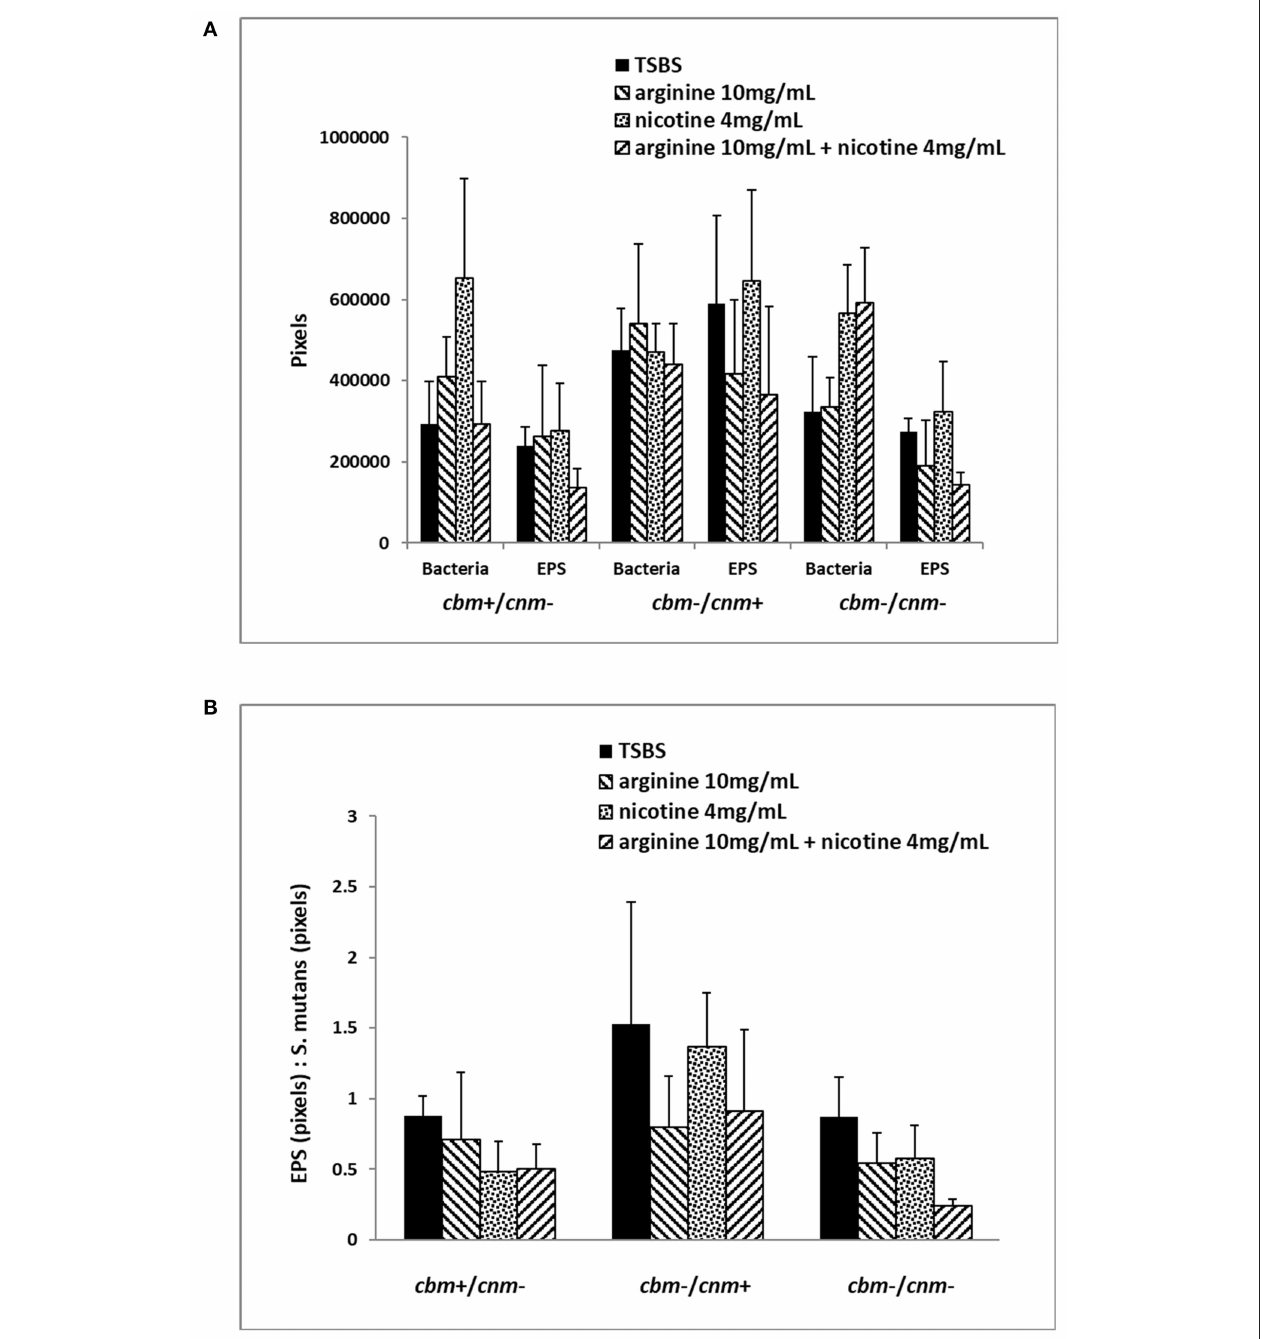
FIGURE 3 | Six selected strains of S. mutans bacterial cells representing cbm + / cnm -, cbm -/ cnm + and cbm -/ cnm - genotypes were used for comparison of bacterial cell mass and EPS in 24h biofilm as measured by CLSM. The effects of 10 mg/ml arginine, 4 mg/ml nicotine and the combination on S. mutans biofilm were quantified by CLSM. Alexa Fluor 568 labeled dextran was added at the beginning of biofilm formation to label the EPS as it was synthesized. Arginine and nicotine were added simultaneously with the Alexa Fluor 568 labeled dextran. Prior to imaging the 24h biofilm, S. mutans DNA was labeled with Syto 9. Biofilm grown in TSBS alone (black) was compared to biofilm grown with 10 mg/ml arginine (black and white diagonal), 4 mg/ml nicotine (gray) and 10 mg/ml arginine plus 4 mg/ml nicotine (black and gray diagonal). Panel (A) shows the total pixels representing bacterial cell mass and EPS for each genotype of S. mutans tested by CLSM. Panel (B) compares the ratio of EPS to S. mutans bacterial cells for each genotype and treatment.